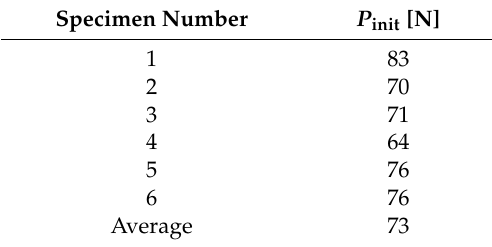
Figure 9. Typical load-crosshead displacement curve during test (Specimen No. 2). Table 11. Crack initiation load ( P init ) obtained by interface fracture test.